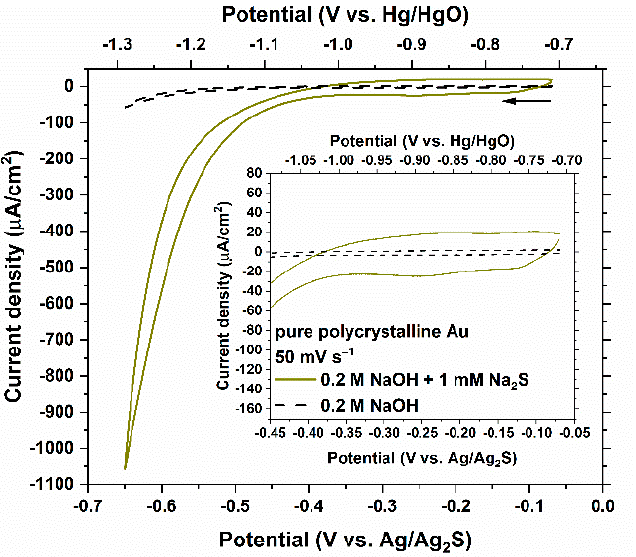
Figure 3. Cyclic voltammetry of a polycrystalline Au wire (0.17 cm 2 ) in 0.2 M NaOH solution with and without 1 mM Na 2 S at a scan rate of 50 mV s − 1 . The insert shows a more refined scale. The arrow indicates the starting point and the scan direction.